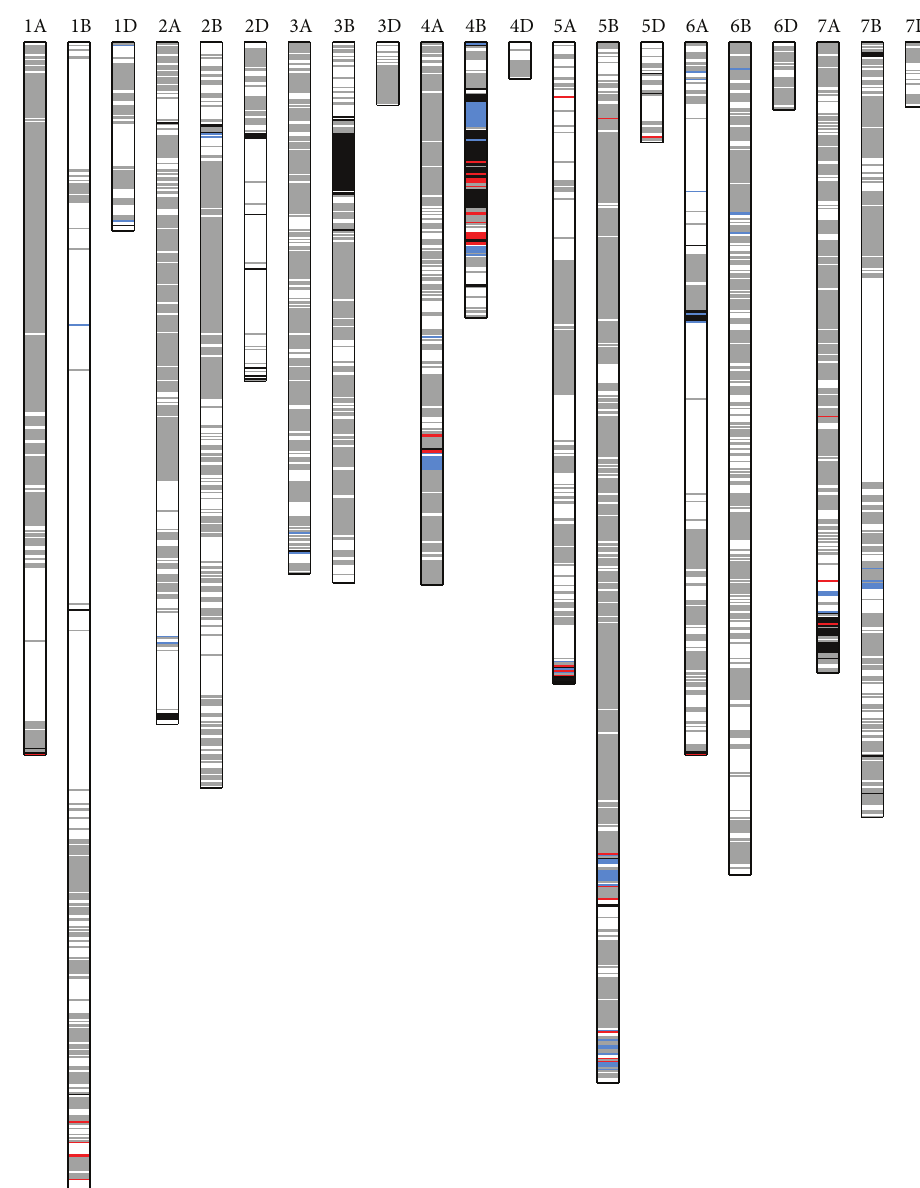
Figure 2: Genetic contribution of Ningmai 9 to Ningmai 13 and Yangfumai 4. White regions are identical sections in Ningmai 9, Ningmai 13, and Yangfumai 4; red regions are different sections among Ningmai 9, Ningmai 13, and Yangfumai 4; blue regions represent different section of Ningmai 13, and gray regions represent different section of Yangfumai 4; and black regions are identical sections between Ningmai 13 and Yangfumai 4, but different from Ningmai